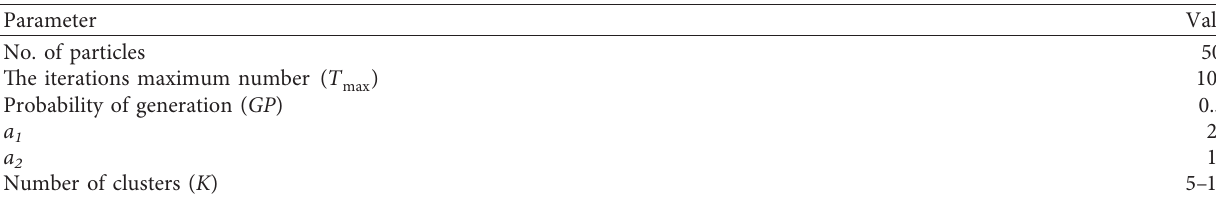
Table 3: The proposed algorithm